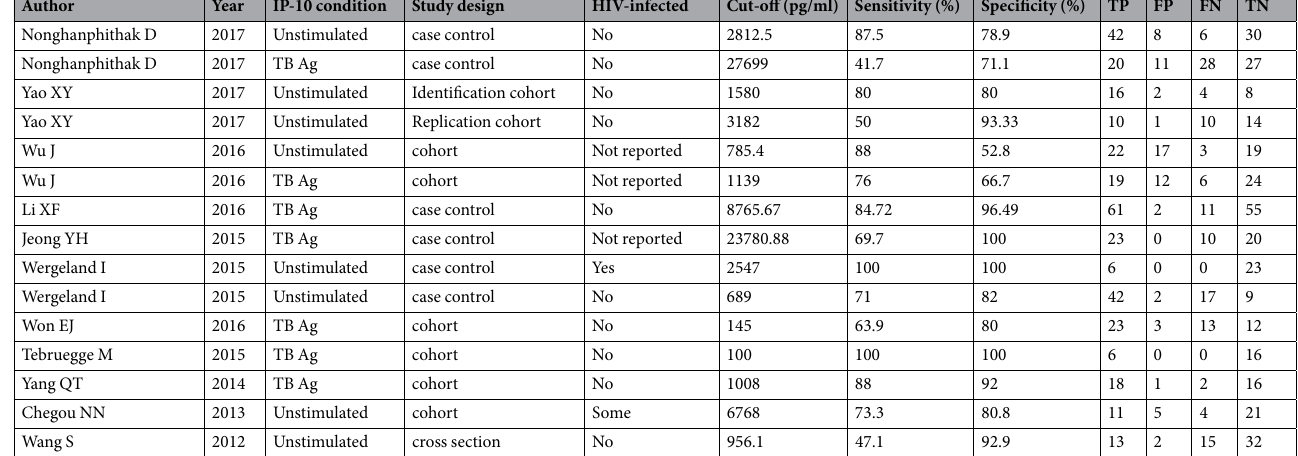
Table 2. Baseline data of included studies. TP: true positive, FP: false positive, FN: false negative, TN: true